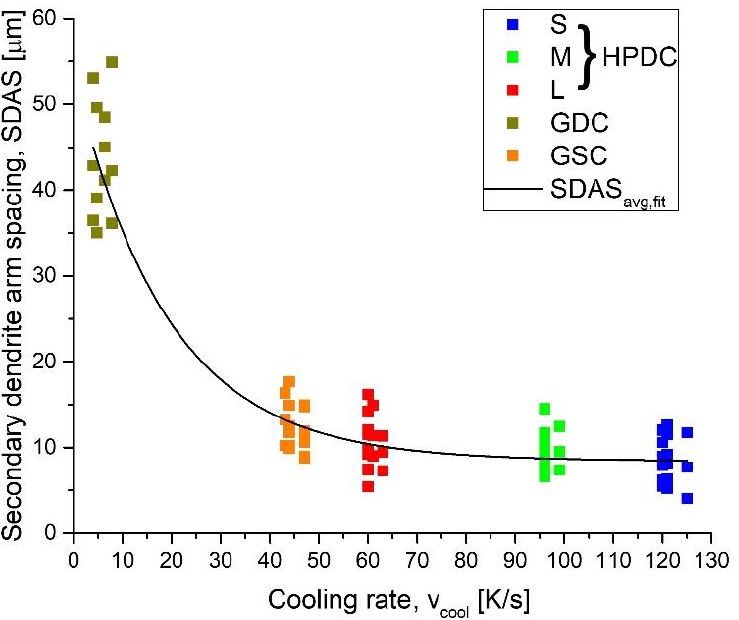
Figure 6. Diagram of SDAS with dependence on cooling rate. As described in the experimental section, compression tests were performed on the specimens at room temperature. The stress–strain curves for each specimen were obtained during the compression test. For illustration, the stress–strain curves are shown in Figure 7 for specimens of casting No. 5. Figure 7 shows how the mechanical properties of each specimen were determined from the graphs. The curves show the mechanical properties and their dependence on the cooling rates, that is, on the specimen diameters or wall thicknesses of the castings from which they were taken. Reproducibility was seen in castings 1 to 5, and the values for R 5 were always highest for the smallest specimens where the cooling rates were highest. Especially for the smaller specimens (medium and small size), there were often sudden stress drops during the test (i.e., when the first cracks started), which may be related to the porosities in the samples typical of HPDC castings. It is interesting to note that these sudden falls were more common in medium-size and small specimens. The reason could be that the material of smaller specimens had a higher strength ( σ ) and was therefore more brittle, and the material of large specimens was more ductile due to the different cooling rates. The values for strength at 5% of combined elastic and plastic deformation ( R 5 ), strength at first fracture ( R f ), and strain at first fracture ( ε f ) were determined from these diagrams and are shown in Table 4. It can be seen that the mechanical properties at the level of the individual casting decreased with decreasing cooling rate, which had already been predicted on the basis of microstructural analyses, and on the basis of knowledge of the relationship between the sizes of the microstructural constituents and the mechanical properties (Hall–Petch relationship